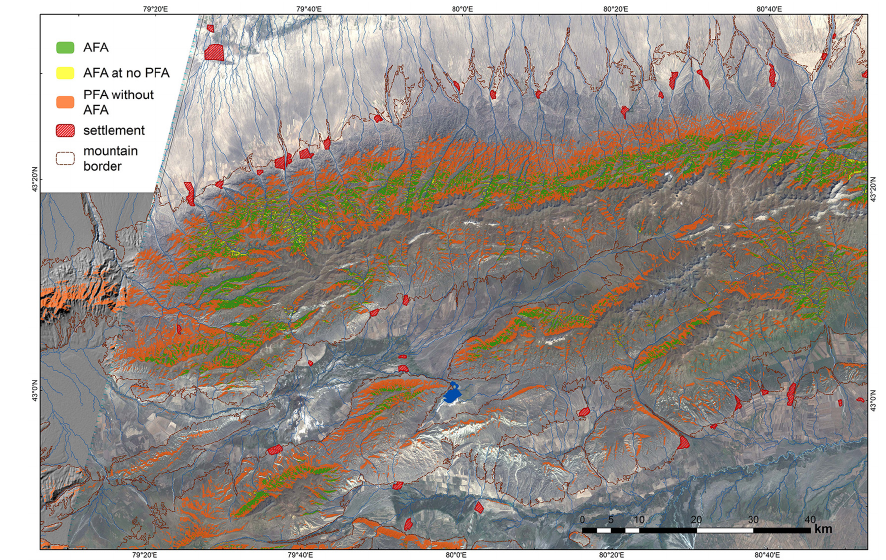
Figure 3. Spatial distribution of actual forested area (AFA) and potential forest area (PFA) in the mountainous region of the northernmost Tien Shan shown above a true-color composite of a Landsat 7 satellite image from the 13 September 2000. Table 1. Confusion matrix showing the accuracy report of the supervised maximum likelihood classification (area in